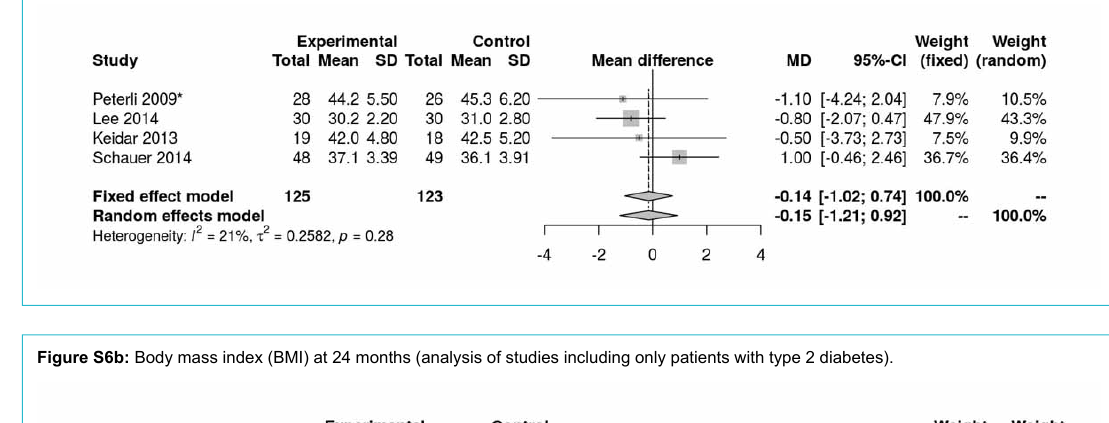
Figure S6a: Body mass index (BMI) at baseline (analysis of studies including only patients with type 2 diabetes).